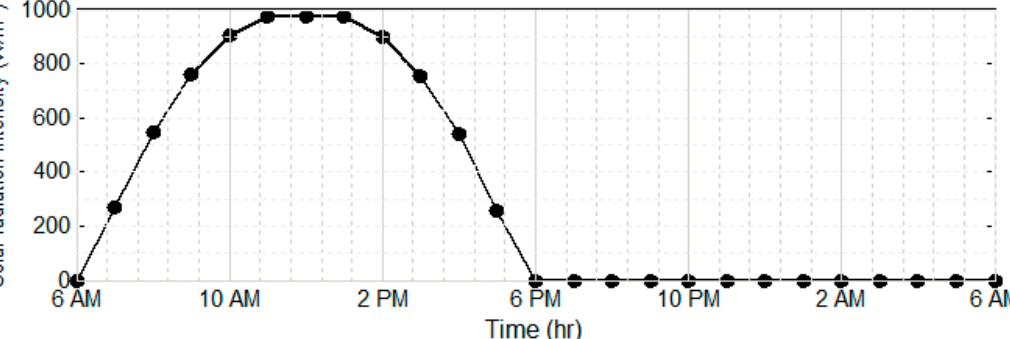
Figure 23. Solar radiation—Egyptian GH—for a typical day of 21st March, Borg El-Arab, Egypt.